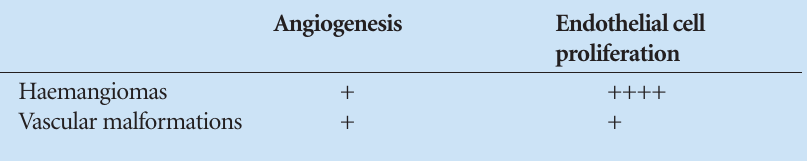
Table III.Characteristics of haemangiomas and vascular